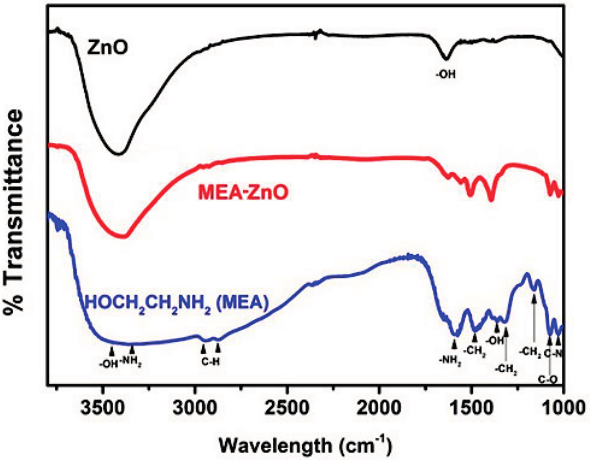
Figure 3. FT-IR spectra of clean ZnO, MEA–ZnO, and the pure MEA